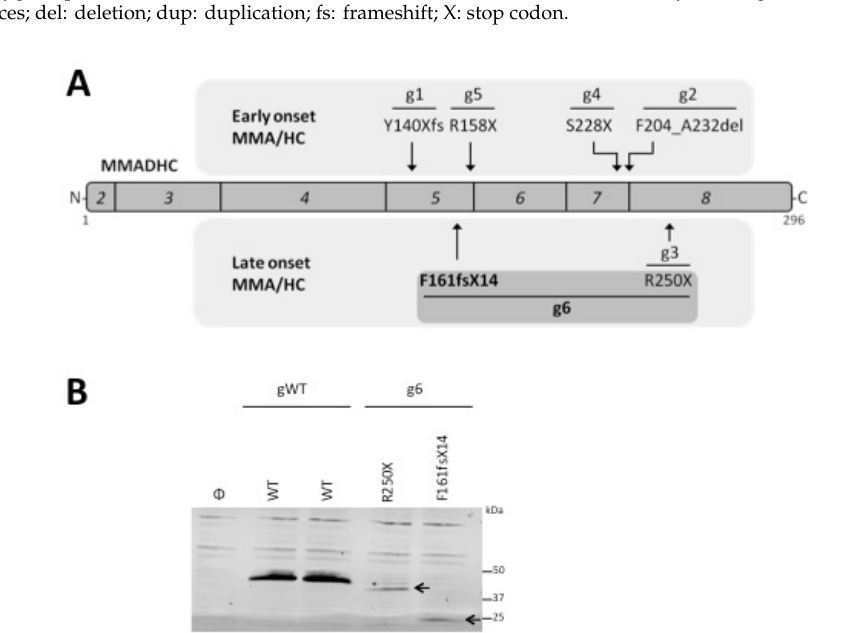
J. Clin. Med. 2020 , 9 , x FOR PEER REVIEW heterozygous patient with MMA / HC cblD defect. 3 Amino acids are indicated by the single-letter code. Ref: references; del: deletion; dup: duplication; fs: frameshift; X: stop codon.